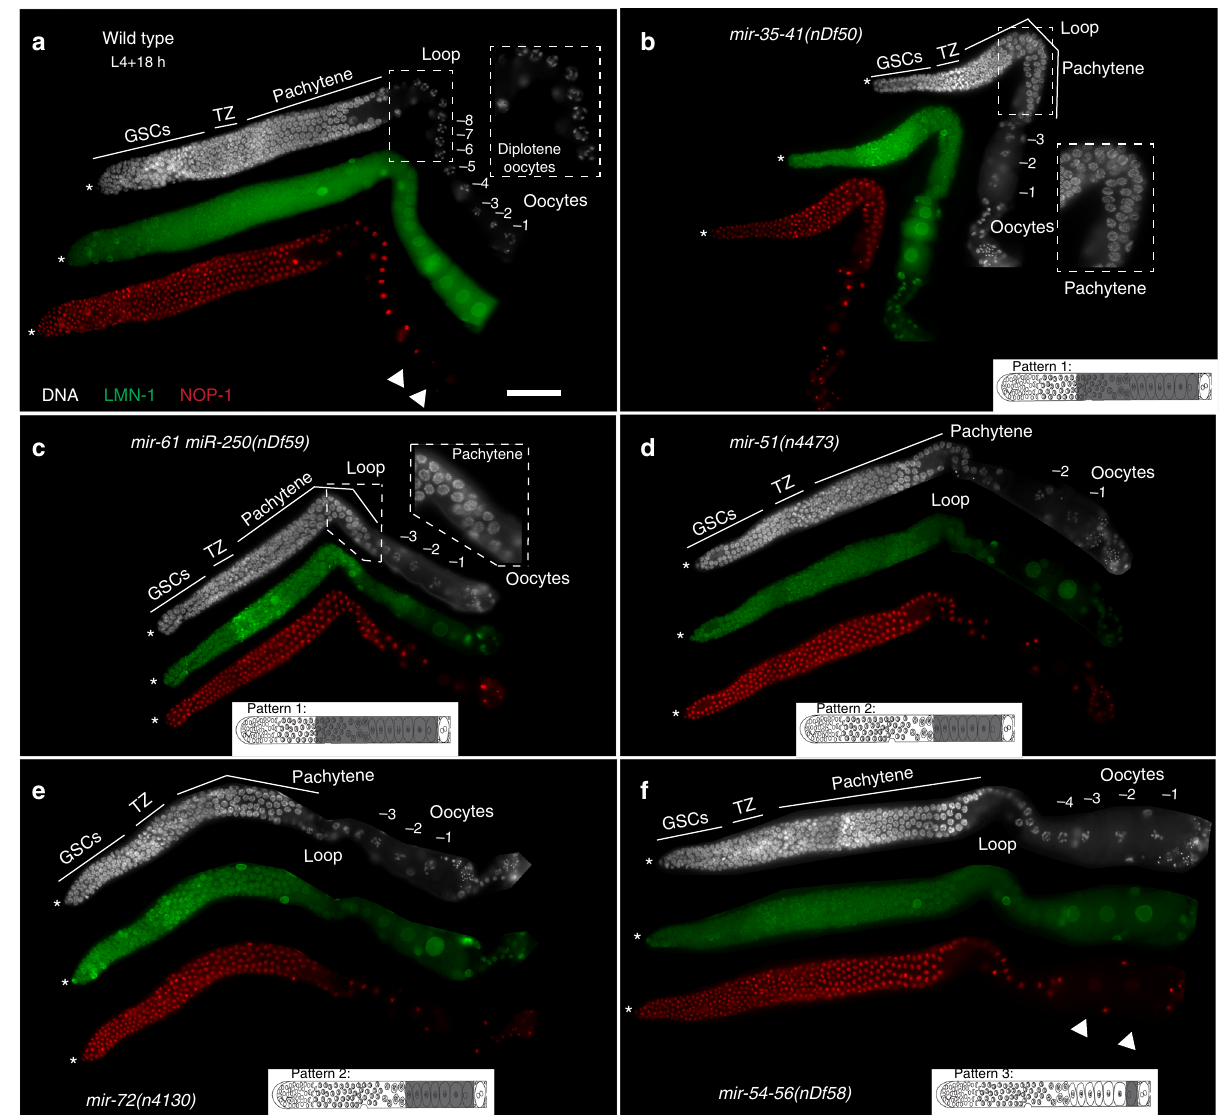
Fig. 3 Oocyte-expressed miRNAs regulate meiotic progression, and oocyte development. Dissected germlines stained with DAPI to visualize nuclear morphology (DNA, white), NOP-1 (nucleolus, red), and LMN-1 (lamin, green) oriented from left to right with oocytes on the right. Asterisk marks the distal tip cell. The schematic in each panel is indicative of miRNA localization (in gray) in an adult germline. a Wild-type germlines exhibit 7 – 8 oocytes with no oogenic defects. b mir-35 – 41(nDf50) , mutant germlines display pachytene progression defects (inset shows pachytene cells in the loop region, where normally germ cells exit into diplotene in wild-type) and reduced oocyte number relative to wild-type at 24 h past L4 stage of development. c mir-61 mir- 250(nDf59) , mutant adult germlines display delayed pachytene progression and reduced oocyte number. d mir-51(n4473) , mutant adult germlines display lower oocyte number compared to wild-type. e mir-72(n4130) , mutant adult germlines display reduced oocyte number compared to wild-type. f mir-54 – 56 (nDf58) , mutant adult germlines display lower oocyte number, with each oocyte also exhibiting abnormal shape relative to wild-type. NOP-1 is abrogated in the -2 oocyte (arrow) unlike wild-type germlines ( a , arrow), where NOP-1 is visible in the -2 oocyte. Each experiment was performed three times, 50 – 75 gonads were dissected for each replicate from each genotype, and ~20 – 25 germlines were imaged per replicate. Scale bar: 20 μ organization of diplotene oocytes. Because Pattern 2 miRNAs localize starting at diplotene oocytes in the hermaphroditic germline (Fig. 2), we surmise that the defect in diplotene organization may be due to the function of these miRNAs to regulate the transition of chromosomes from pachytene or diplotene of meiosis or they may function to organize the linear row of growing diplotene oocytes (Fig. 4h). In addition, the (n4473) and mir-72(n4130) mutant hermaphroditic animals as mutant hermaphroditic animals from each miRNA displayed a well in animals treated with RNAi for mir-51 and mir-72 reduction in brood size (Fig. 5a). Once born the embryos from (Figs. 3d, e and 4d, e, g), relative to wild-type germlines. RNAi mir-51(n4473) and mir-72(n4130) mutant hermaphroditic ani- analysis of each of the two miRNA genes also revealed non-linear mals were viable (Fig. 5b). These data suggest that Pattern 2